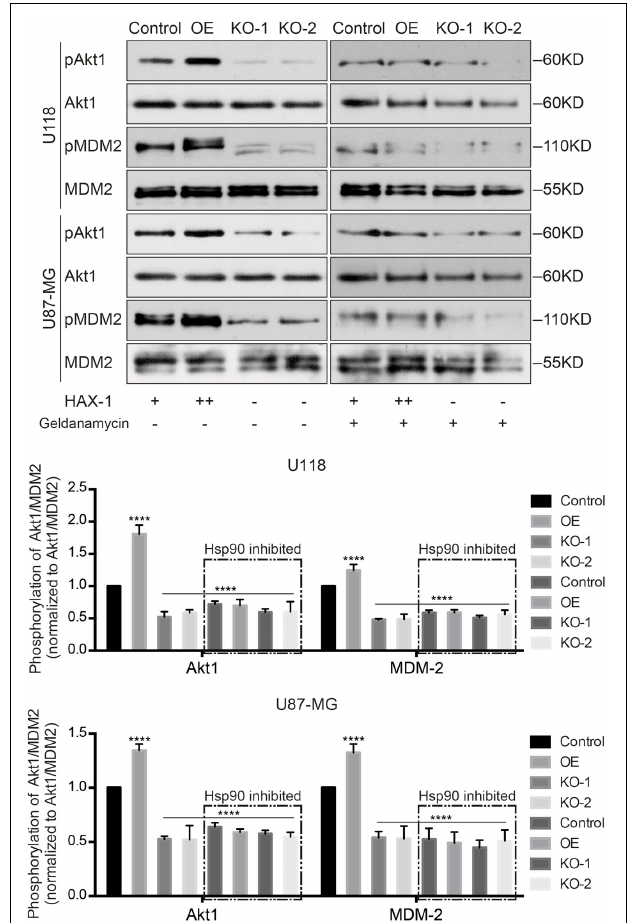
FIGURE 9 | Inhibition of Hsp90 could block the effect of HAX-1 on Akt1. Western blot showed the changes the phosphorylation of Akt1 and MDM-2 induced by HAX-1 alteration were obviously diminished after Hsp90 was inhibited. GAPDH, Akt-1, MDM-2 were used as loading control. Three individual experiments were performed for each group. ∗∗∗∗ P <